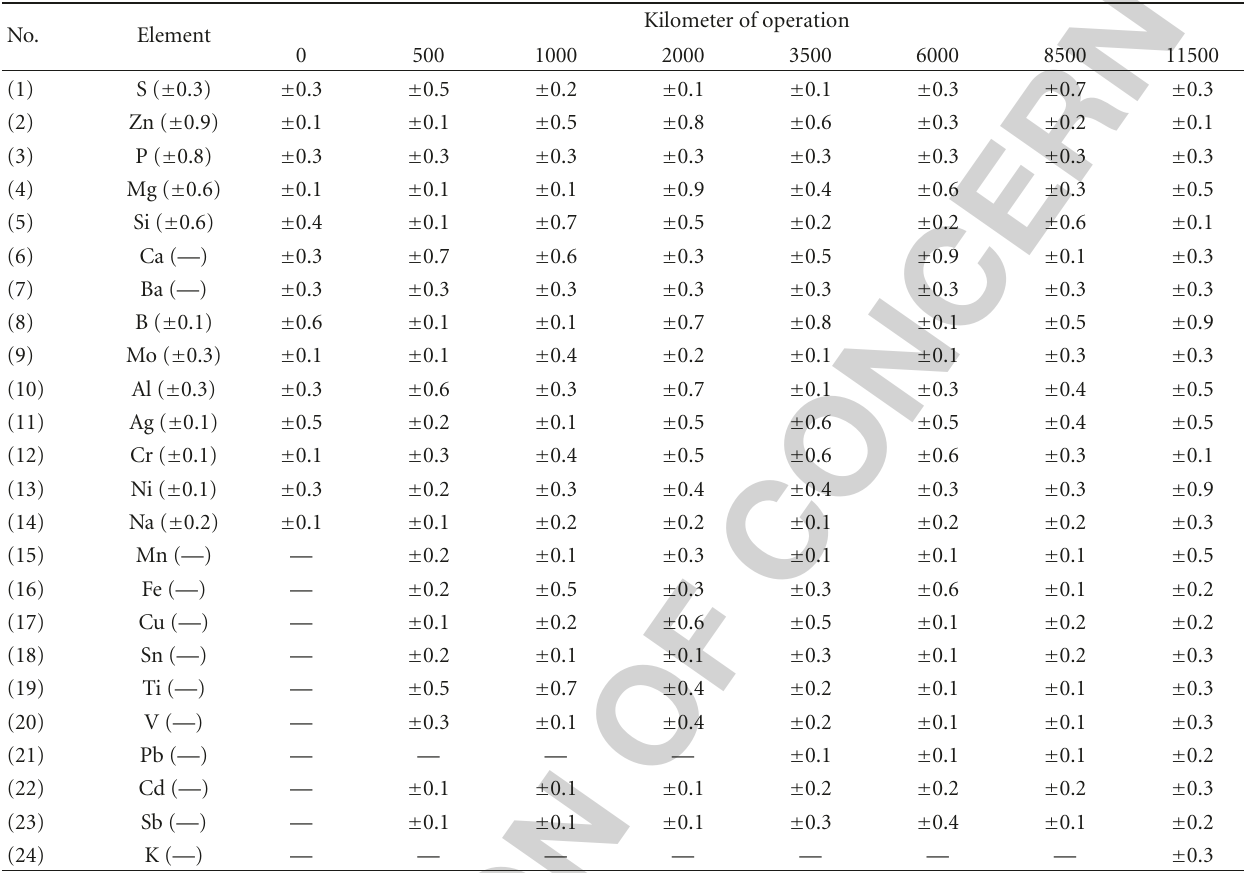
Table 2: Standard deviations of the data of Table